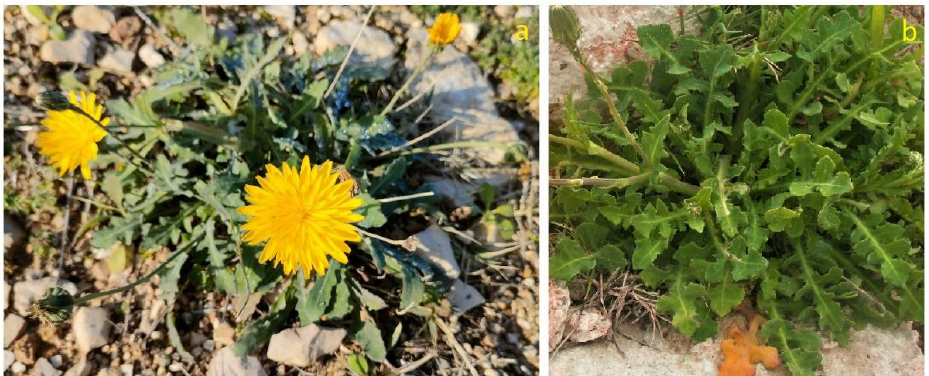
Figure 11. Reichardia picroides : flower heads ( a ) and basal rosette ( b ).